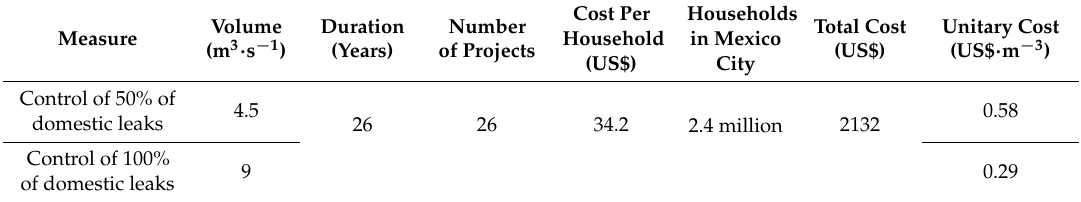
Table 7. Financial assumptions for decentralized measures of leak control in Mexico City.